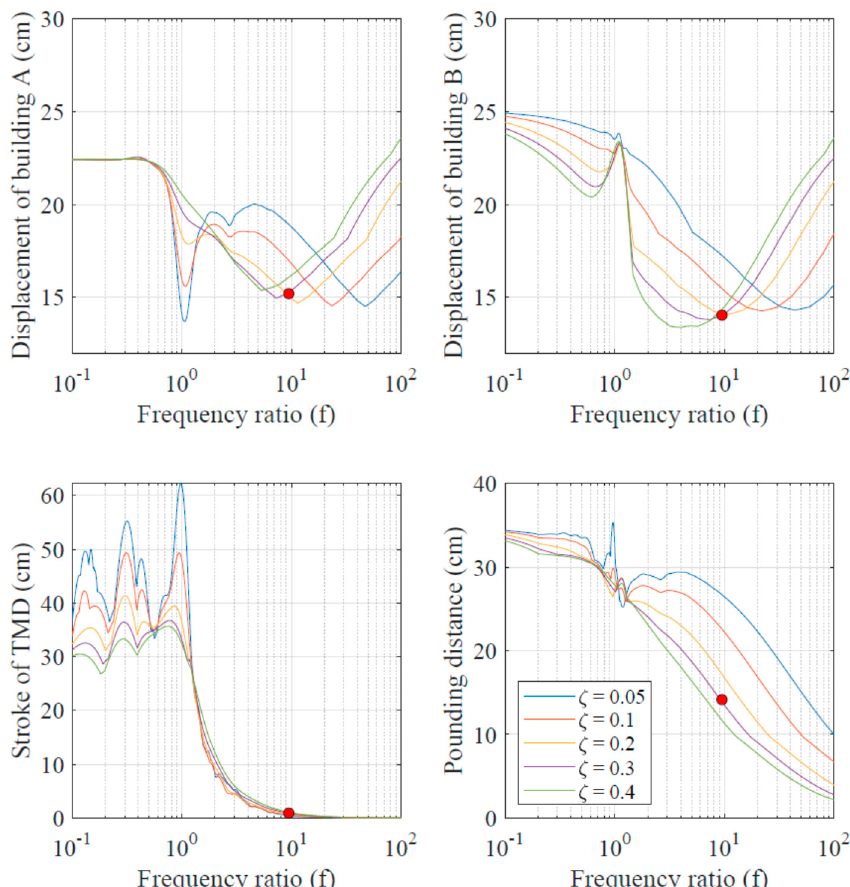
Figure 6. Peak roof displacements, device stroke, and the minimum separation distance between two buildings connected by an STMD. The optimal solution presented in Abdullah [28] is shown with red dots. The results correspond to El Centro ground motion.